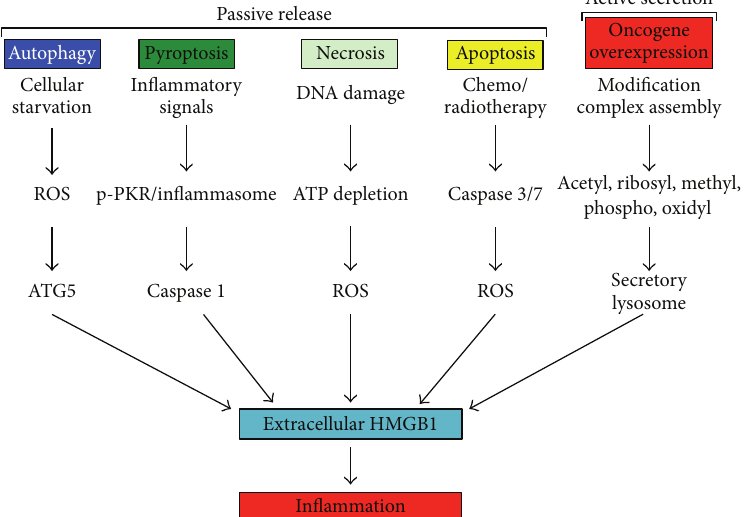
Figure 1: HMGB1 and inflammation. The forces contributing to the passive release and the active secretion of HMGB1 from tumor cells within the aggressiveness